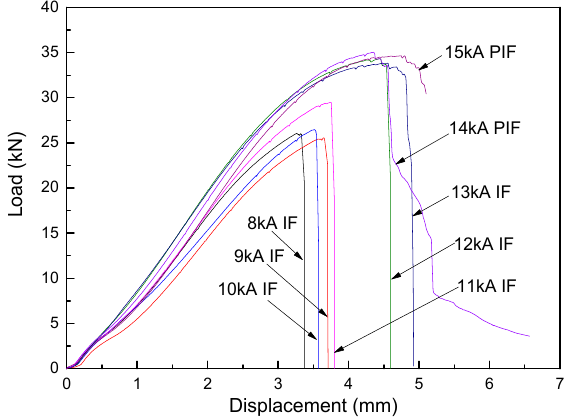
Figure 12. Representative load-displacement curves under various welding current with constant welding time of 20 cyc.